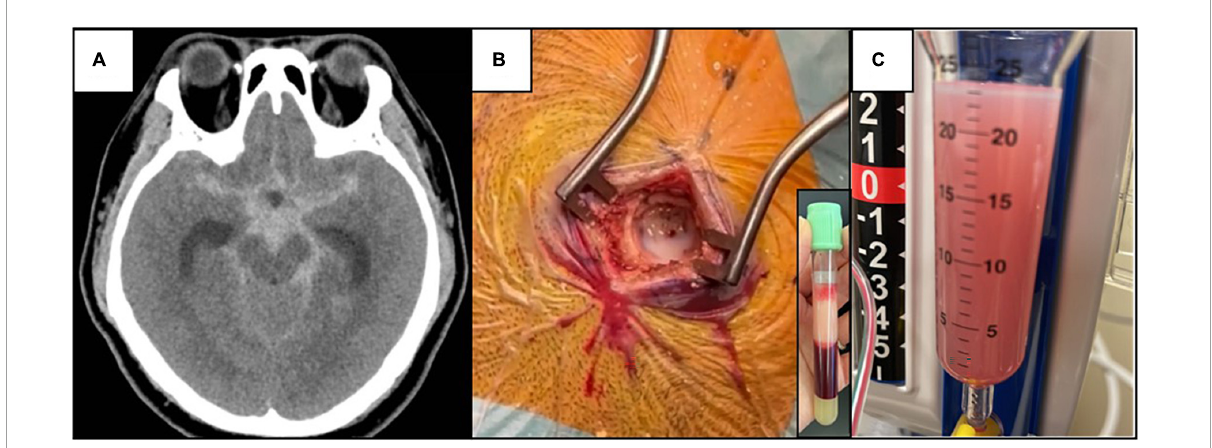
FIGURE1 (A) Non-contrast CT brain showing extensive subarachnoid hemorrhage centered at the suprasellar and interpeduncular cisterns with cerebral edema. (B) Lactescent subarachnoid hemorrhage was seen during operation (CSF TG level of 6 · 88 mmol/L), and the corresponding lipemic blood plasma due to hypertriglyceridemia (serum TG level of 52 · 4 mmol/L). (C) Blood-stained turbid CSF in the tubing connected to the external ventricular drain, day 2 after the